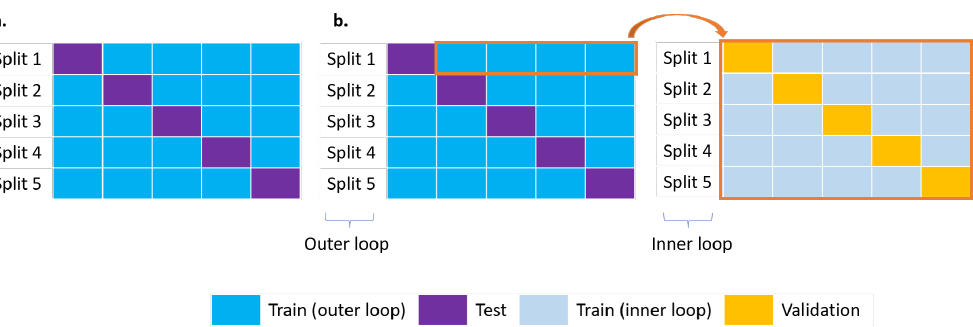
Figure 3. Data partitioning procedures: ( a ) 5-fold cross-validation procedure for ML models screening without HP optimization. ( b ) Nested cross-validation with 5-fold outer and 5-fold inner cross- validation procedures for combined model selection and HP